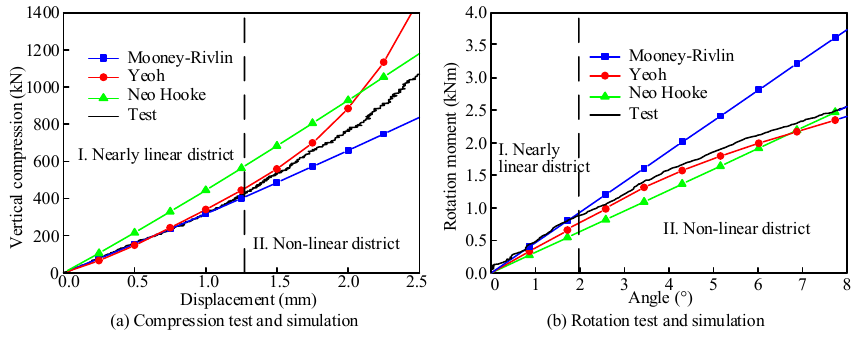
Figure 11. The FEM simulation and test results.